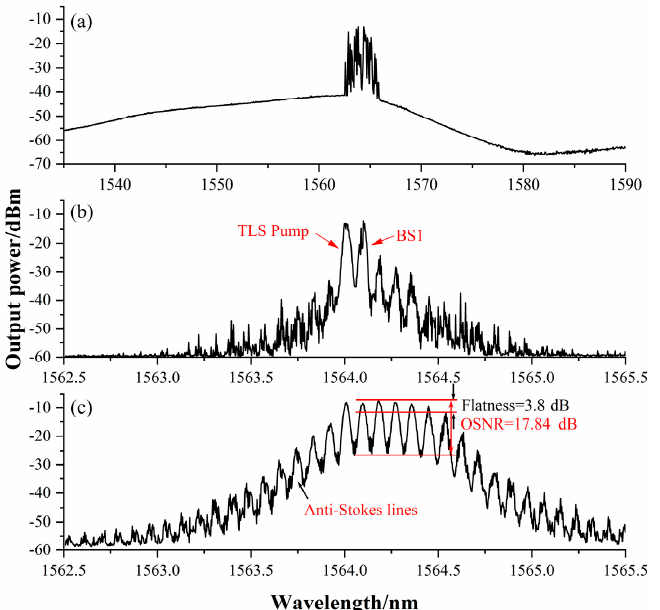
Figure 4. ( a ) ASE and self-excited light without the use of the TLS pump; ( b ) the output spectrum obtained when the 980 nm pump power was 54 mWl ( c ) the output spectrum obtained when the TLS pump power was 14 dBm and the 980 nm pump power was 500 mW. As shown in Figure 4c, when the TLS pump power was increased to 14 dBm and the 980 nm pump power was increased to 500 mW, the number of Stokes lines increased to 6, and the flatness was 3.8 dB. Under this experimental scheme, the main factor affecting the number of Stokes lines was the 980 nm pump power (maximum 500 mW). If an EDFA with higher gain was used, more Stokes lines could be saturated, and the absorption of optical power by the Un-EDF and the peak power of the Stokes lines would become flatter. To study the flatness of the output power in the entire flat range, the TLS wavelength was set to six different conditions ranging from 1532 nm to 1565 nm. After setting the TLS wavelength for the first time and flattening the output power by adjusting the two PCs, the states of the two PCs remain unchanged after changing the TLS wavelength again. As shown in Figure 5, the TLS pump wavelength was set at 1532 nm, 1542.5 nm, 1547 nm, 1553 nm, 1559 nm, and 1565 nm, and the peak power of the output spectrum was − 18.19 dBm, − 18.25 dBm, − 18.49 dBm, − 18.18 dBm, − 18.30 dBm, and − 18.75 dBm, respectively. The peak power difference obtained at different central wavelengths was only 0.57 dB; the power flatness ranged from 0.63 dB to 2.76 dB. The number of relatively flat spectral output lines obtained at different wavelengths ranged from approximately four to six, and the power level of the Brillouin Stokes lines between adjacent channels was extremely close to the wavelength interval. The best output power flatness achieved throughout the experiment was 0.63 dB ( ± 0.315 dB), obtained when the TLS wavelength was 1532 nm. The worst power flatness obtained throughout the experiment was 2.76